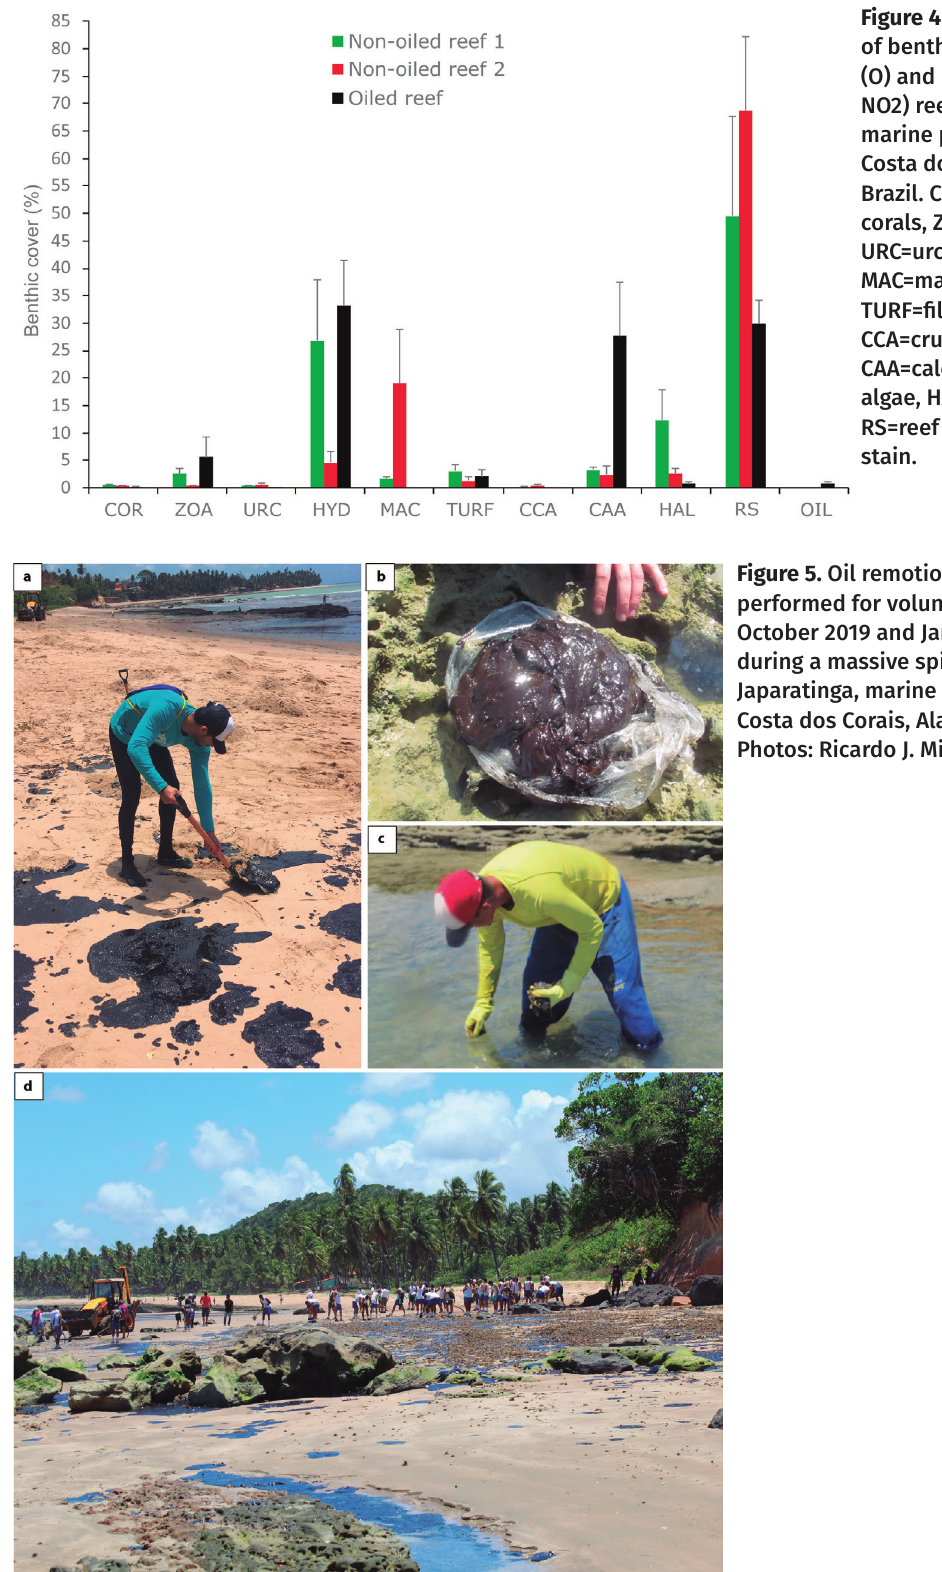
Figure 4. Mean cover (±SE) of benthic groups in oiled